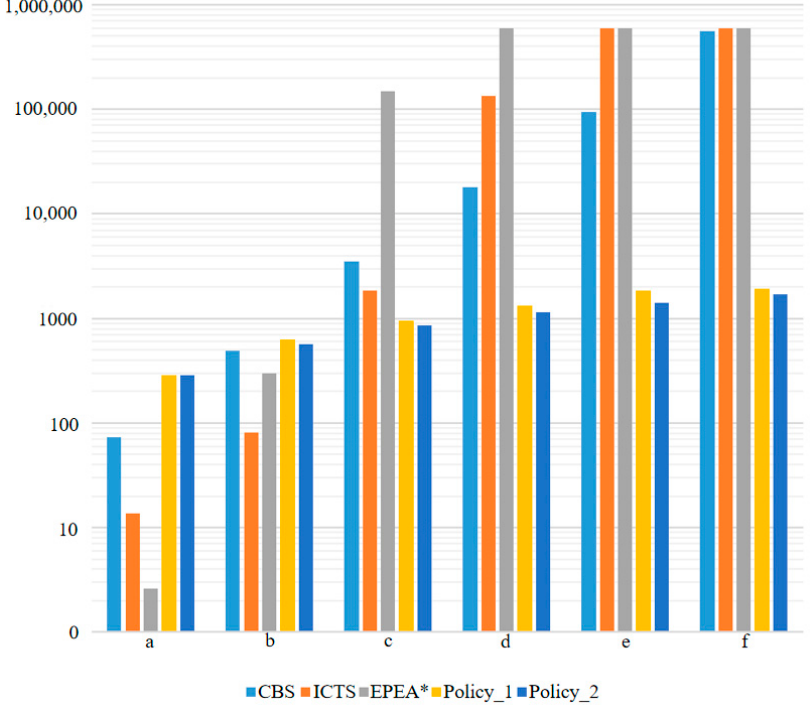
Figure 8. The time-consuming histogram use different methods to calculate the trajectory of the completed task shown in Figure 6. Table 4. Time consumption, in milliseconds (ms). CBS, Conflict-Based Search; ICTS, Increasing Cost Tree Search; EPEA*, Enhanced Partial Expansion A*. Policy